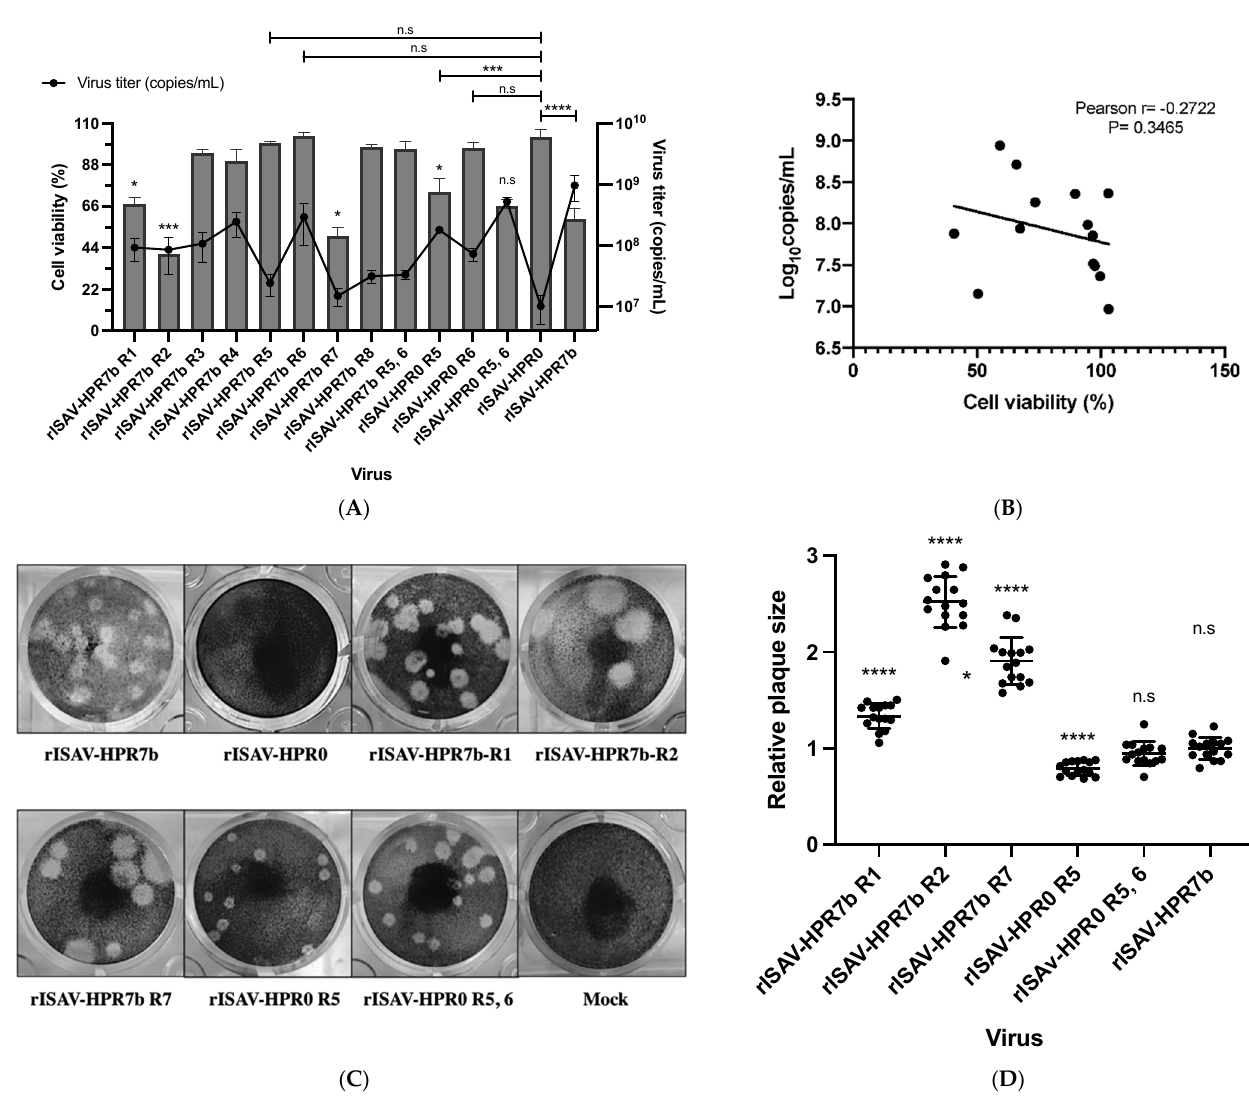
Figure 6. Effect of ISAV segments rearrangement on cell viability and cytopathic effect induction in ASK cells. ( A ) Quantification by MTT assay of cellular viability at 7 dpi (left Y-axis) of ASK cells infected at an MOI of 0.1, contrasting with viral titer (right Y-axis, black line) from infected cells supernatants determined by segment 8 absolute quantitation. ( B ) Pearson correlation analysis of cell viability and viral titer at 7 dpi using the data of ( A ). ( C ) Representative photographs of plaques produced by rISAV in ASK cells at 18 dpi. ( D ) Relative plaque size of the recombinant viruses compared to those produced by rISAV-HPR7b. Cellular viability and viral titer ± SEM from three independent experiments. α = 0.05; * p < 0.05; *** p < 0.0005; **** p < 0.00005; n.s. not significant.